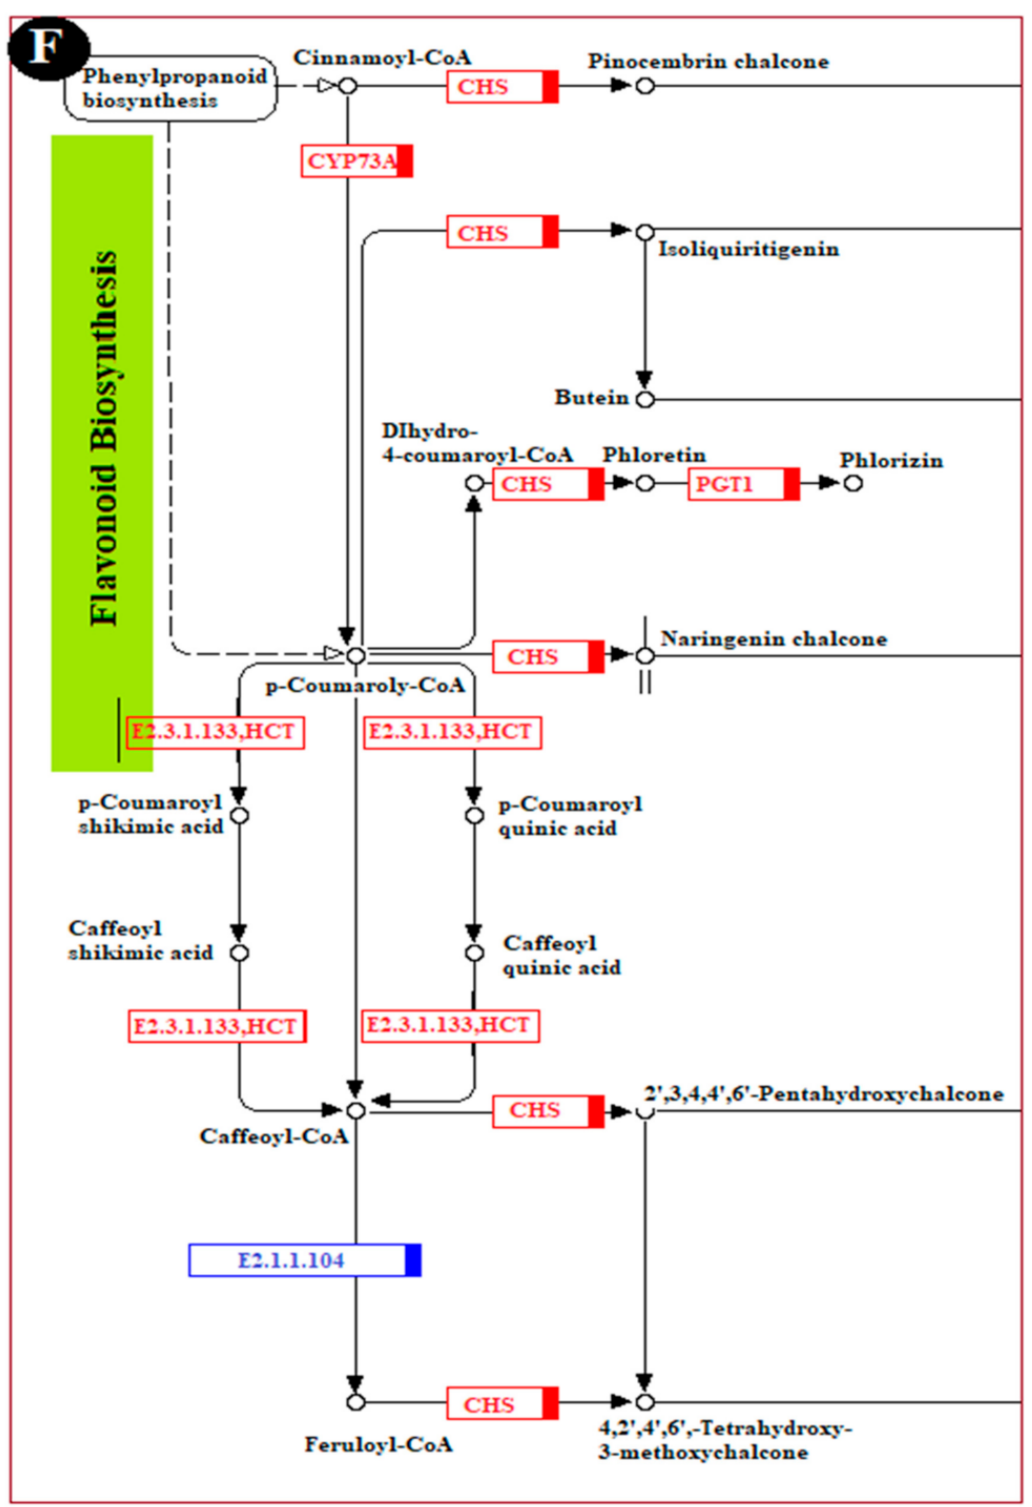
Figure 6. Major pathways related to induced disease resistance of table grapes. ( A ): Plant–pathogen interaction pathway, ( B ): Plant MAPK signaling pathway, ( C ): Plant hormone signal transduction pathway, ( D ): Pathway of glutathione metabolism, ( E ): Pathway of phenylalanine, tyrosine, and tryptophan biosynthesis, and ( F ): Pathway of flavonoid biosynthesis. The genes with the red color are all up-regulated, the genes with the green color are all down-regulated, and the genes with the blue color are